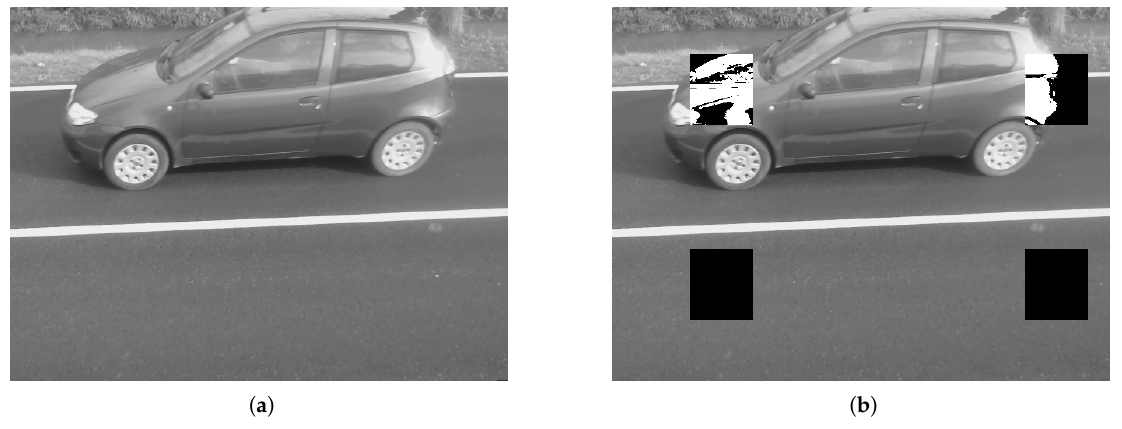
Figure 8. Traffic flow analysis: detected vechicle from sensor test set-up ( a ) and the same frame processed with the RoIs highlighted ( b